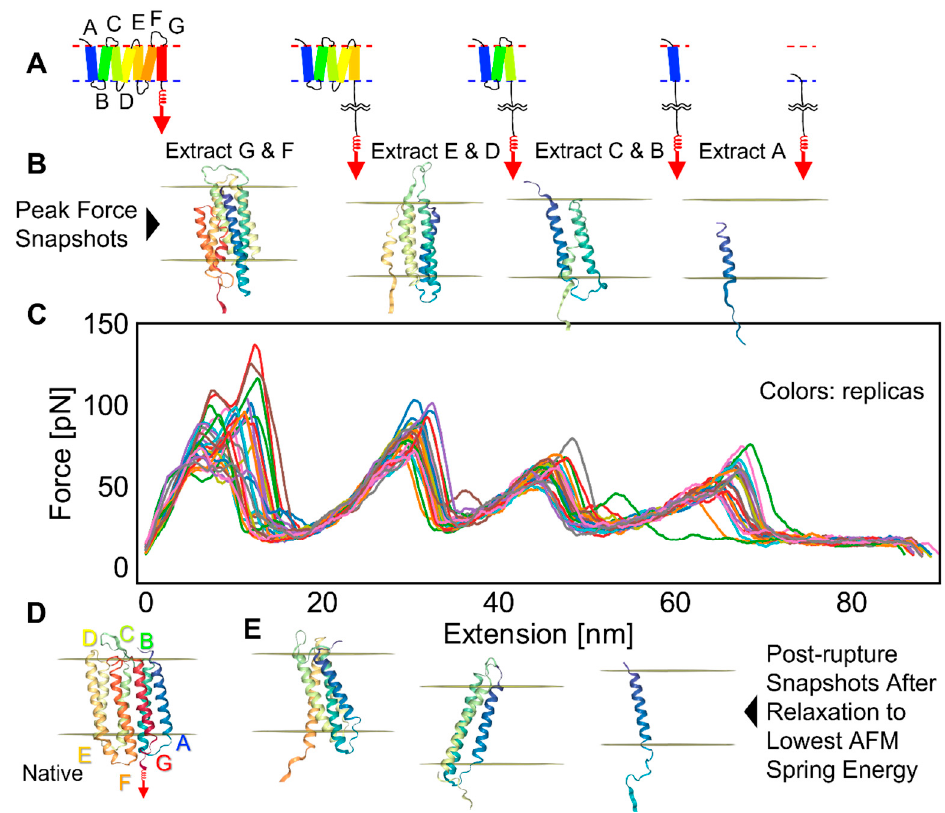
Figure 1. Vertical AFM pulling of bR: ( A ) protein topology and main stages of pulling; ( B ) snapshots from a replica near a rupture event; ( C ) FECs from 28 replicas; ( D ) native structure of bR; and ( E ) snapshots of structures after each rupture at minimum force after AFM spring relaxation. The noticeable divergence of a few FEC profiles is the signature of different unfolding pathways.